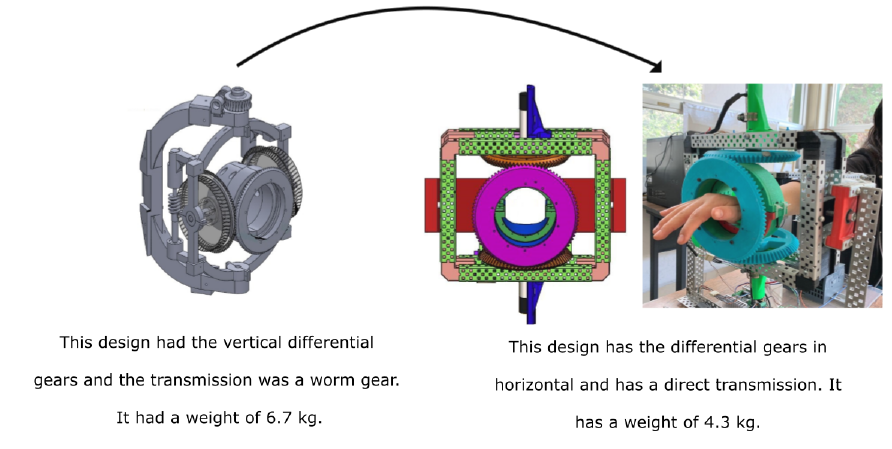
Figure 6. Increasing of technology readiness level TRL for the wrist